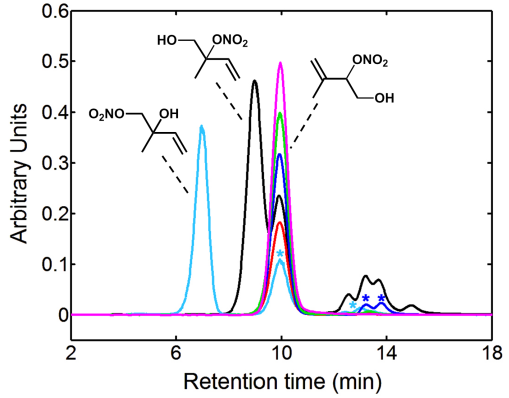
Figure 4. GC-ToFCIMS chromatogram of ISOPNs from an iso- prene high-NO photooxidation experiment (black), and from the introduction of 2,1-ISOPN standard synthesized by CSUF (cyan) and 4,3-ISOPN standards synthesized by Caltech (magenta), CSUF (green), UCB (blue), and Purdue (red). The rightmost four peaks ap- parent in the photooxidation chromatogram are preliminarily iden- tified as the cis and trans 1,4-ISOPN and cis and trans 4,1-ISOPN, although the elution order is not clear. Asterisks ( ∗ ) denote impuri- ties in synthesized samples of corresponding color.